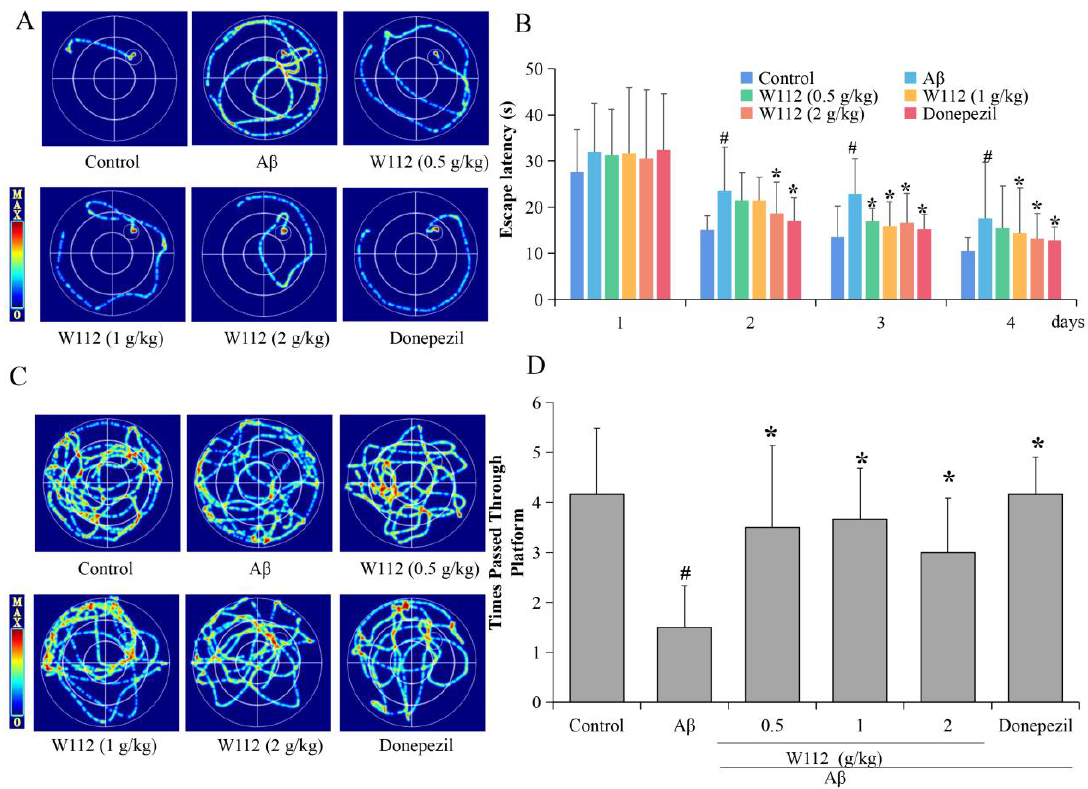
Figure 2. W112 treatment improved cognitive impairments of AD rats. ( A , B ) The representative swim paths and the escape latency. ( C , D ) The representative swim paths and the number of platform crossings. n = 12. # p < 0.05 vs. the control group; * p < 0.05 vs. the model group.